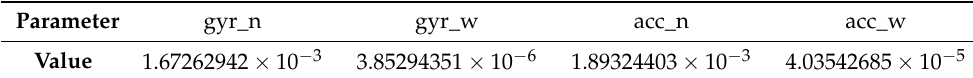
Table 2. Internal parameters of